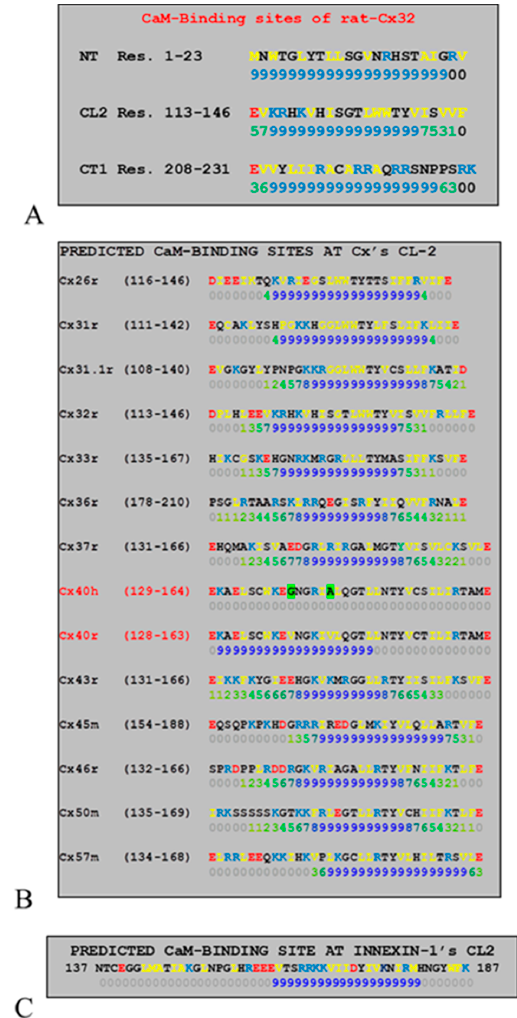
Figure 5. Most connexins have three CaM-binding sites. The CaM-binding sites of rat-Cx32: NH 2 -terminus (NT), second half of the cytoplasmic loop (CL2) and initial domain of the COOH-terminus (CT1) are shown in ( A ). Most relevant for chemical gating is likely to be the CL2 site of connexins ( B ) and Innexin-1 ( C ). The CaM-binding site was identified by a computer program that rate the sites 0–9 [73].